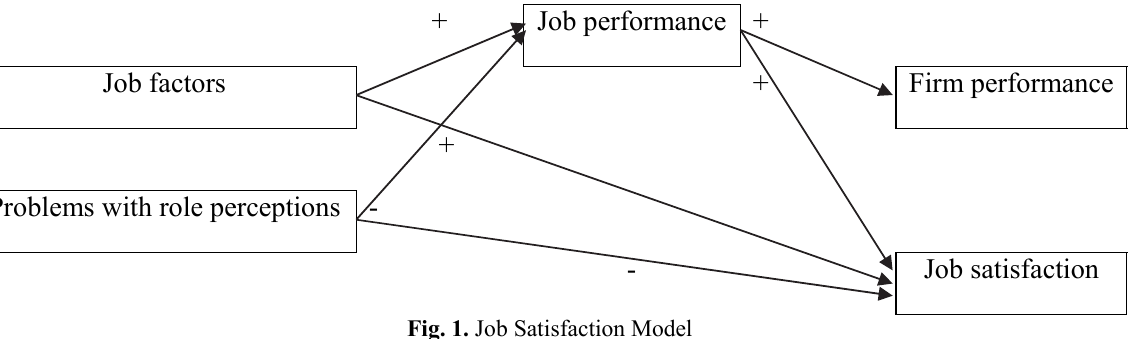
Fig. 1. Job Satisfaction